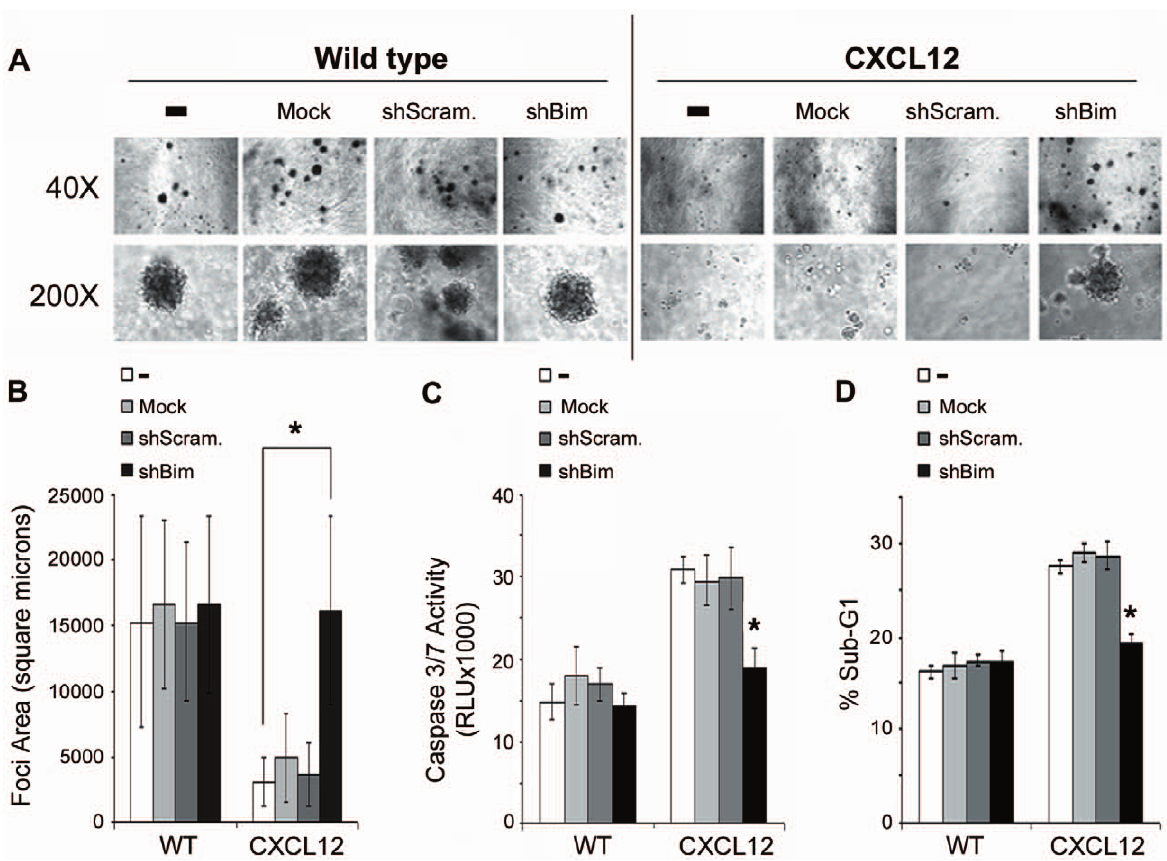
Figure 7. Bim knockdown rescued anchorage-independent growth in CXCL12-expressing colorectal carcinoma cells. (A, B) HCT116 stable cell lines were grown for two weeks on soft-agar to examine anchorage-independent cell growth. Foci formation was examined using bright field microscopy under 40X and 200X objectives. Bim knockdown rescued anoikis resistance in CXCL12-expressing colorectal carcinomas to equivalent levels as GFP controls. (C) Cells were cultured 4-days as a suspension on poly-HEMA treated plates and caspase-3/7 activity measured. Depletion of Bim in CXCL12 cells decreased caspase-3/7 activity to GFP control levels. (D) Sub-G1 populations indicating DNA degradation were diminished with Bim knockdown in CXCL12-expressing cells but not in control cells. Values are mean 6 SD of three independent experiments completed in triplicate. * indicates statistically significant between CXCL12 untransduced and transduced cells (P # 0.05).